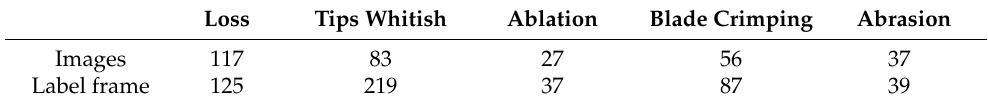
Table 3. Damage statistics in air compressor/turbine blades